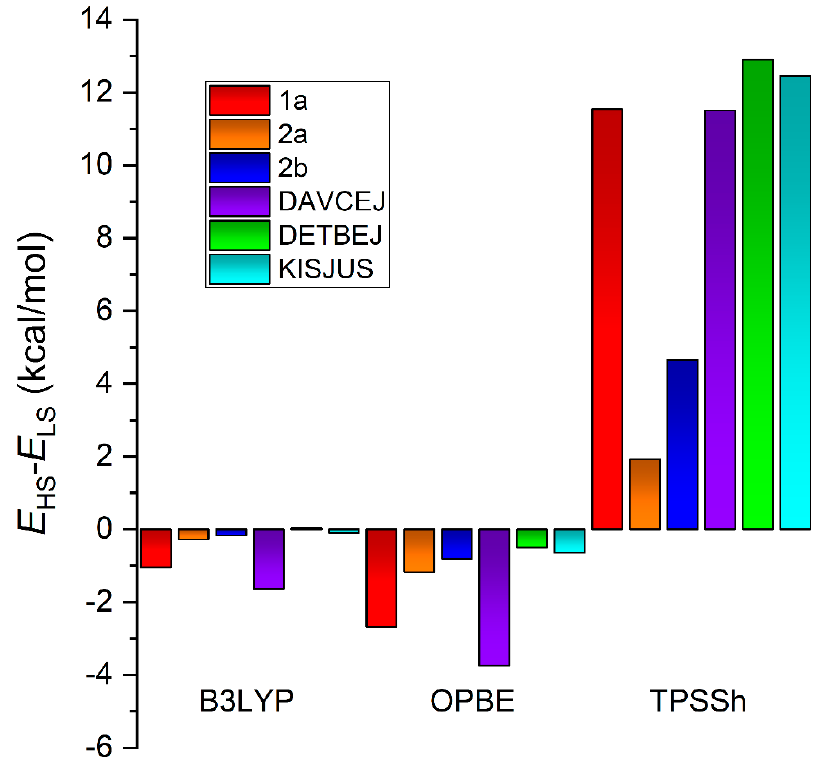
Figure 4. The energy separation of HS and LS states of 1a , 2a , and 2b and DAVCEJ, DETBEJ, and KISJUS calculated using B3LYP, OPBE, and TPSSh with the def2-TZVP basis set.